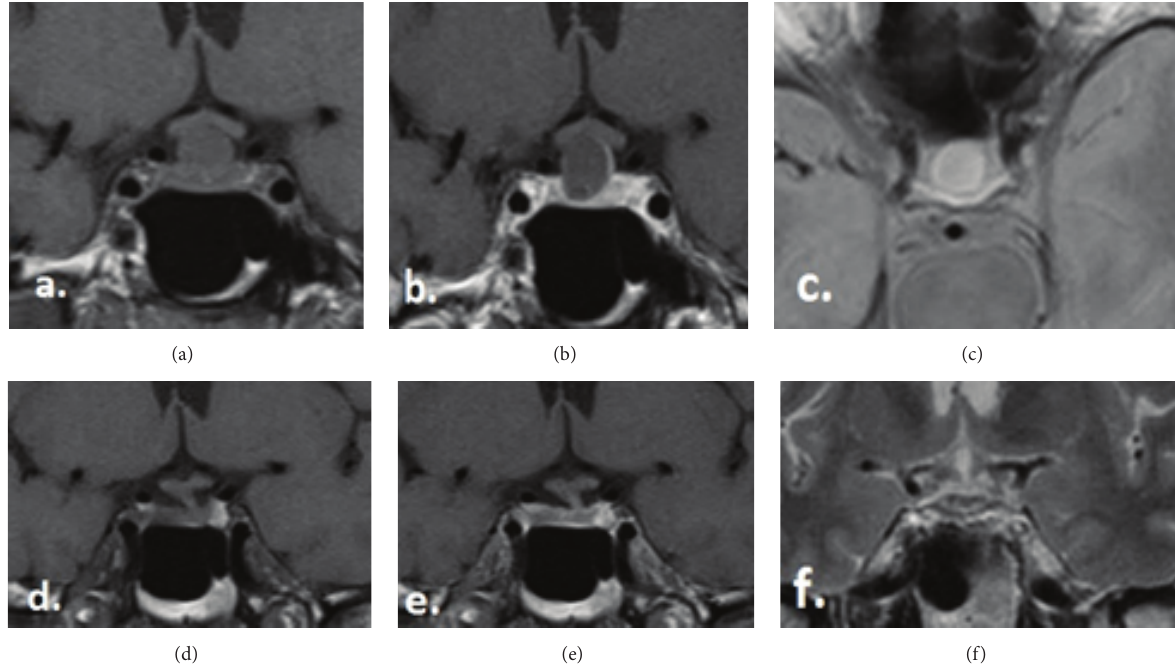
Figure 1: (a–c) The MRIimages by theinitial diagnosis, (a) T1-coronal without contrast, (b) T1-coronal with contrast, and (c) T2-axial without contrast. (d–f) The MRI images by the 1-year follow-up, (d) T1-coronal without contrast, (e) T1-coronal with contrast, and (f) T2-coronal without